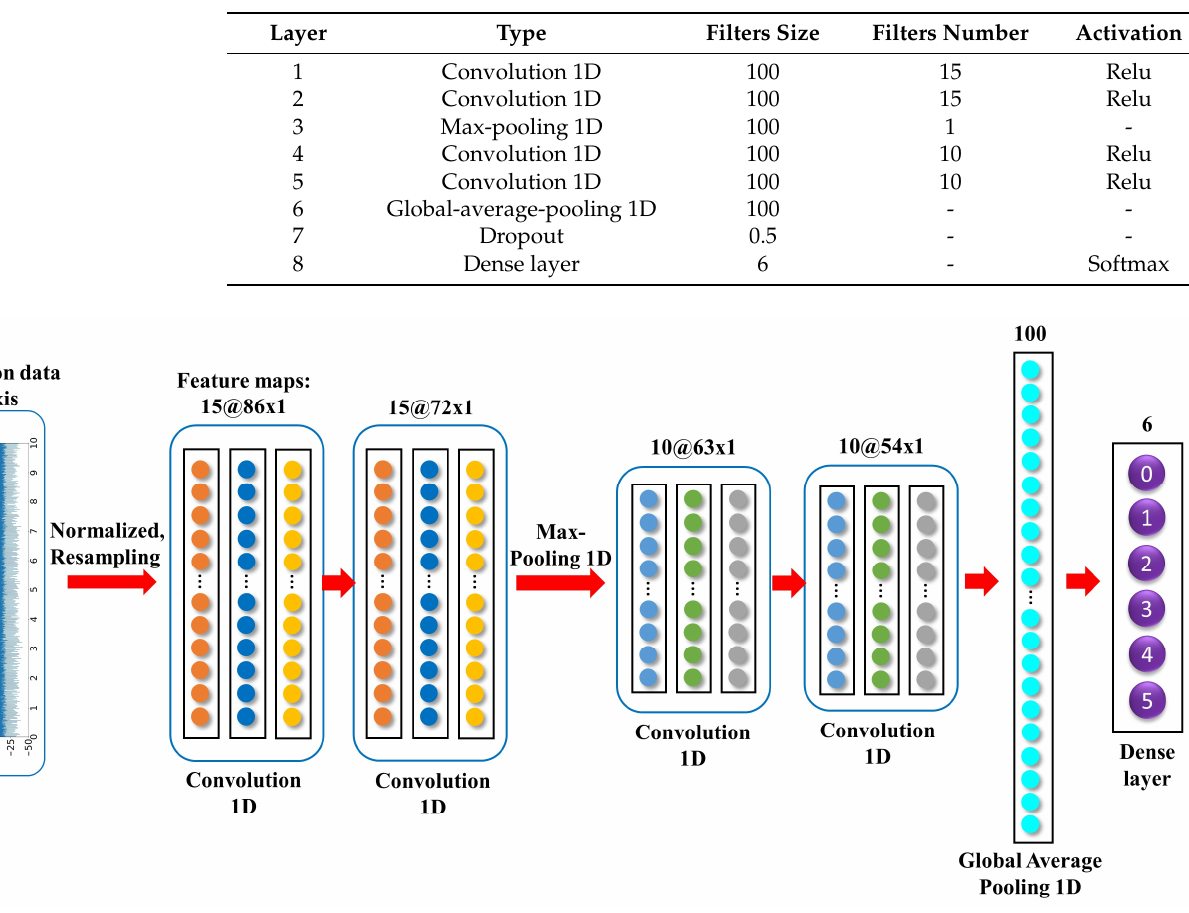
Figure 5. Internal structure of 1D CNN.